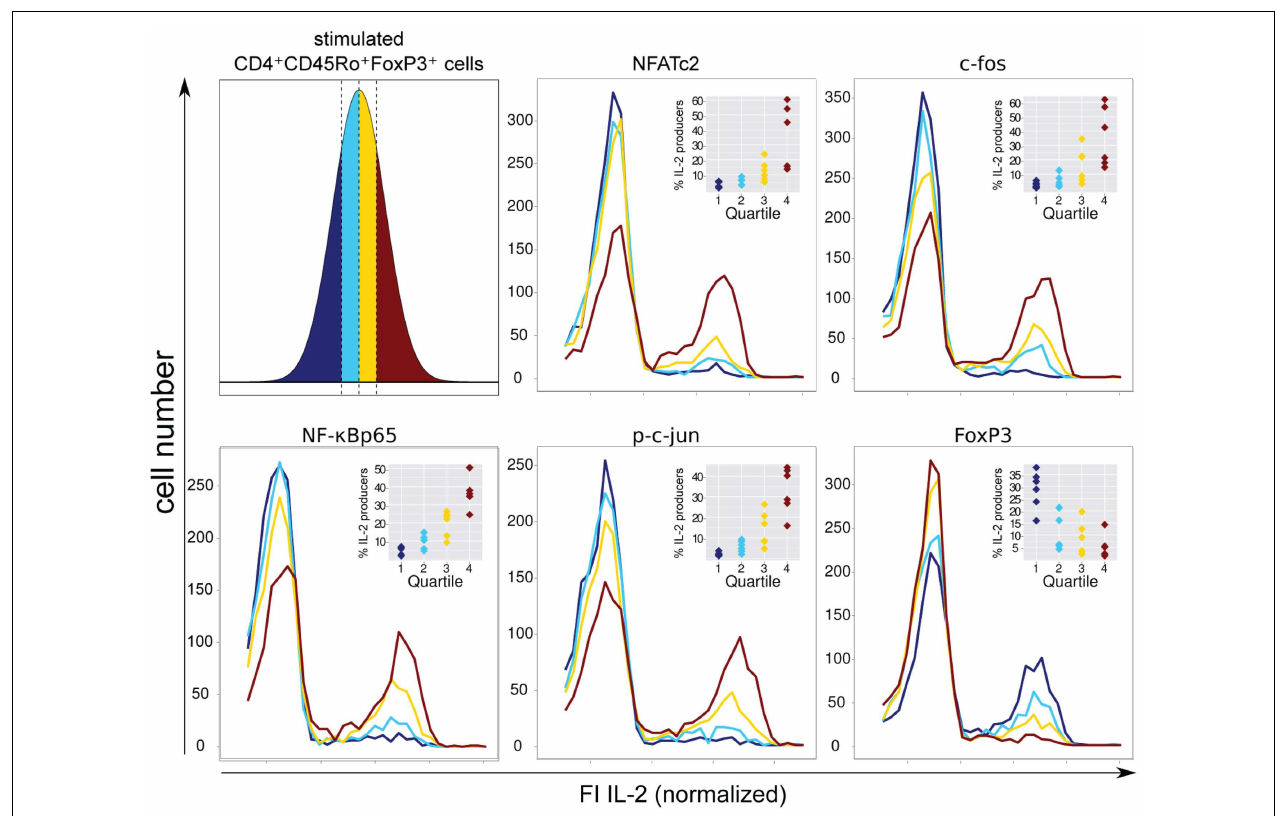
scale using the asinh function. Subsequently, the range of transcription factor expression level was divided into quartiles (with the same cell number) according to the level of expression of each transcription factor at single cell level (upper left).The effect of different transcription factor expression levels on IL-2 expression is shown in histogram overlays of one experiment.The inserts show the frequencies of IL-2-expressing FOXP3 + cells within the quartiles from six different donors.